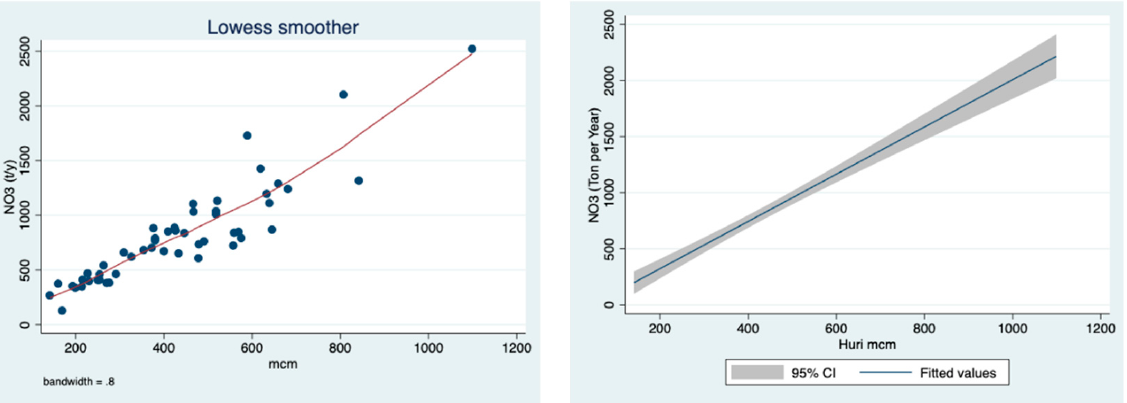
Figure 8. Linear prediction (95% CI) ( left ) and LOWESS smoother (0.8 bandwidth) trend of changes ( right ) between annual means of nitrate concentration (ppm) in River Jordan waters (Huri Station) and years during 1968–2018.